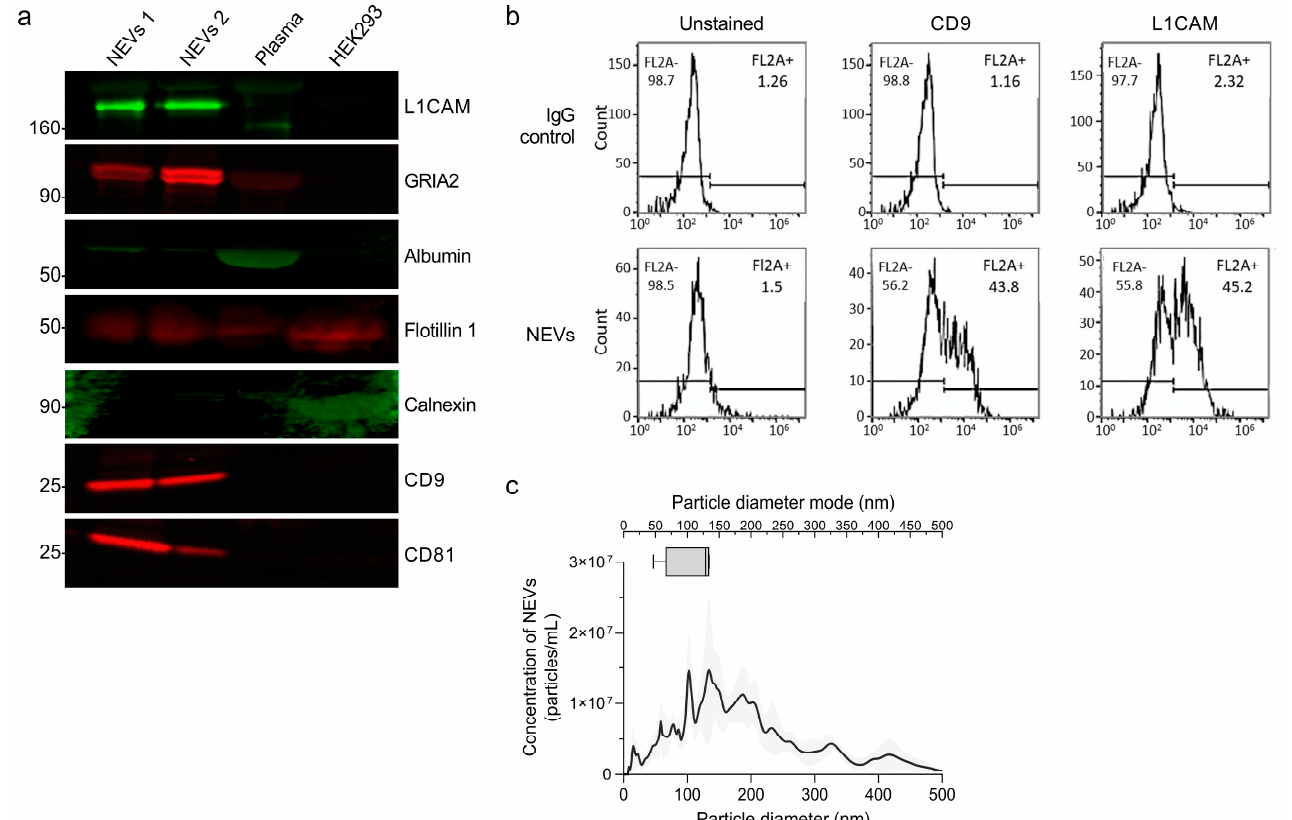
Figure 1. Characterization of extracellular vesicles. ( a ) WBs showing the protein levels of the intra-vesicular EV markers Flotillin 1, and transmembrane EV markers CD9, CD63 and CD81, used as positive EV markers, the neuronal specific markers L1CAM and GRIA2 as indicators of neuronal enrichment, the endoplasmic reticulum marker Calnexin used as a negative EV marker, and albumin as an indicator of peripheral contaminants co-precipitated with EVs, in 20 µ g of NEVs from two WT mice (NEVs 1 and NEVs 2) and 1:50 diluted neat plasma, as well as in 20 µ g of HEK293 cell lysate used as a negative control for the enrichment of neuronal- and EV-specific markers. ( b ) FC analysis of NEVs and non-specific EVs immunocaptured with anti-IgG antibodies fluorescently labelled with antibodies against the EV marker CD9 and the neuron specific marker L1CAM. The fluorescent signal from unstained EVs was used to establish the fluorescence threshold. ( c ) The graph presents EV concentration (particles/EVs per mL) as a function of particle diameter (determined using NTA) for immunoprecipitated NEVs isolated from the plasma of 4 WT mice in duplicate. In the upper part, a box and whiskers graph plots the particle diameter mode range.